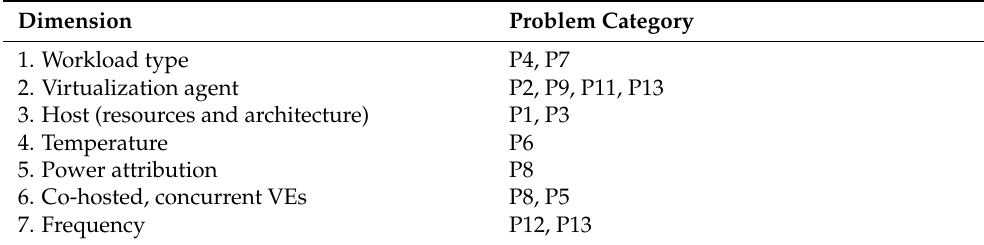
Table 5. Seven dimensions of